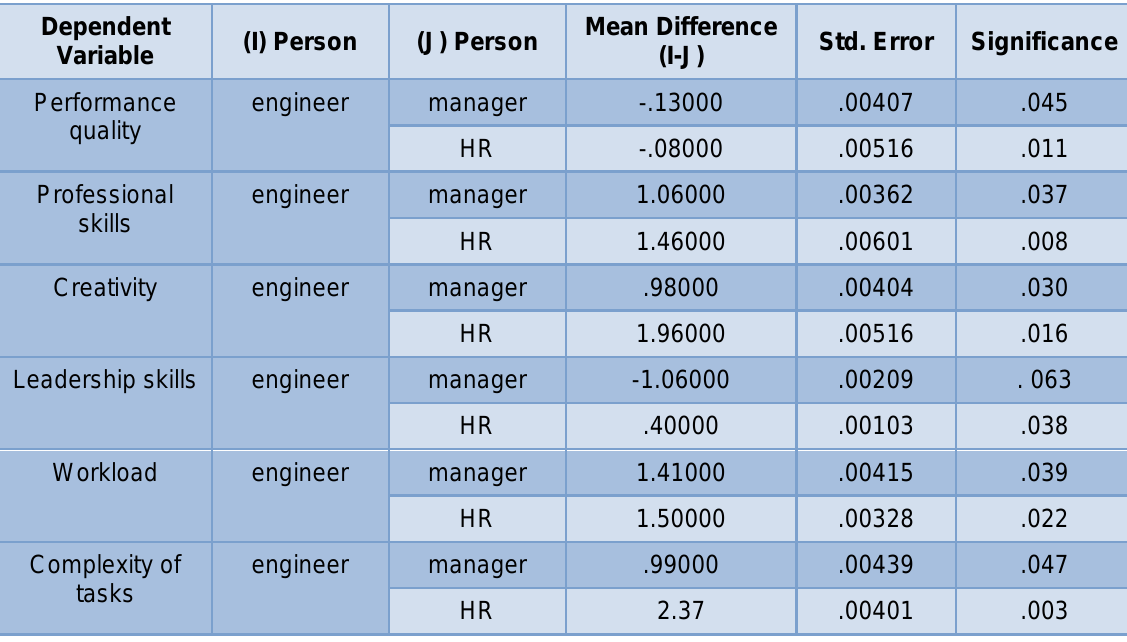
Table 6 Tukey's HSD (honestly significant difference) test: significantly different perspectives among